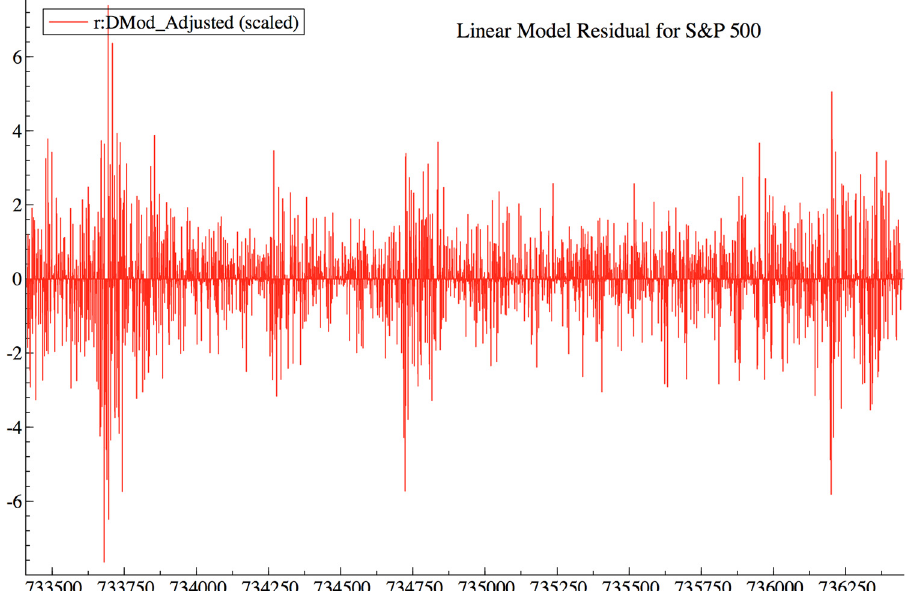
Figure A2: Residuals from the ADL linear predictive model for FTSE 100 Table A3: FTSE 100 returns: GARCH model estimates